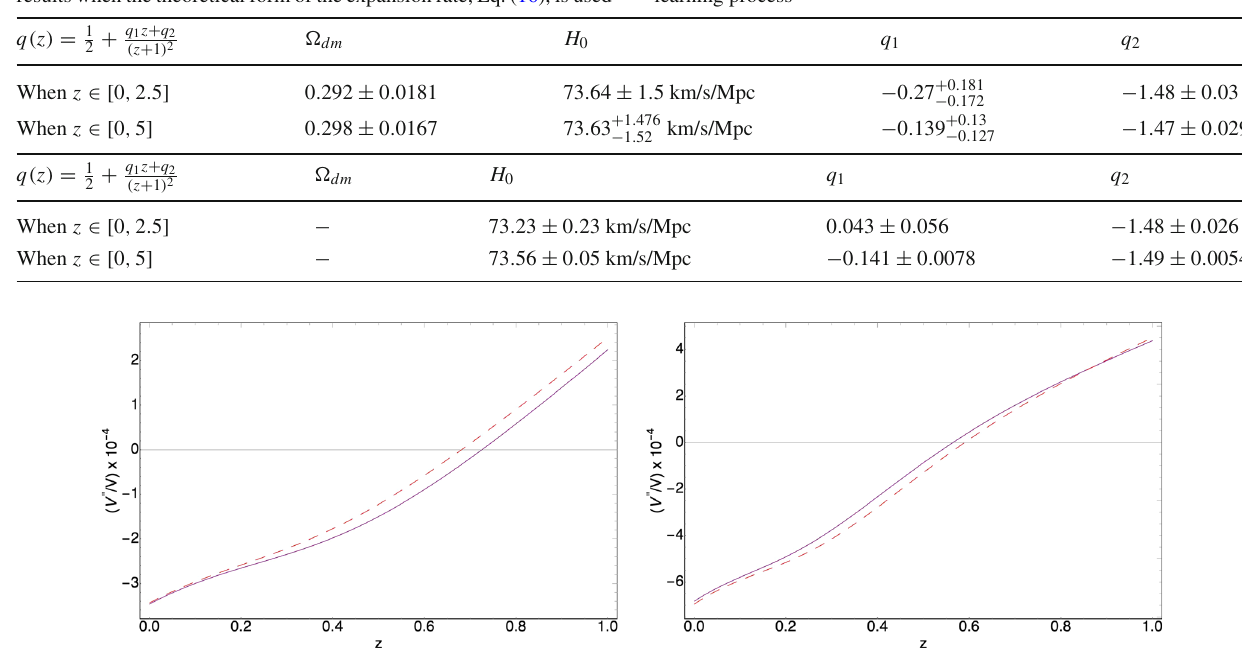
Table 3 Best fit values and 1 σ errors estimated for Model 2, Eq. (16), for z ∈ [ 0 , 2 . 5 ] and for z ∈ [ 0 , 5 ] , respectively. The results presented in the first part of the table are obtained from the generative process based on SC1, Eq. (1). The second part of the table represents the fit results when the theoretical form of the expansion rate, Eq. (16), is used